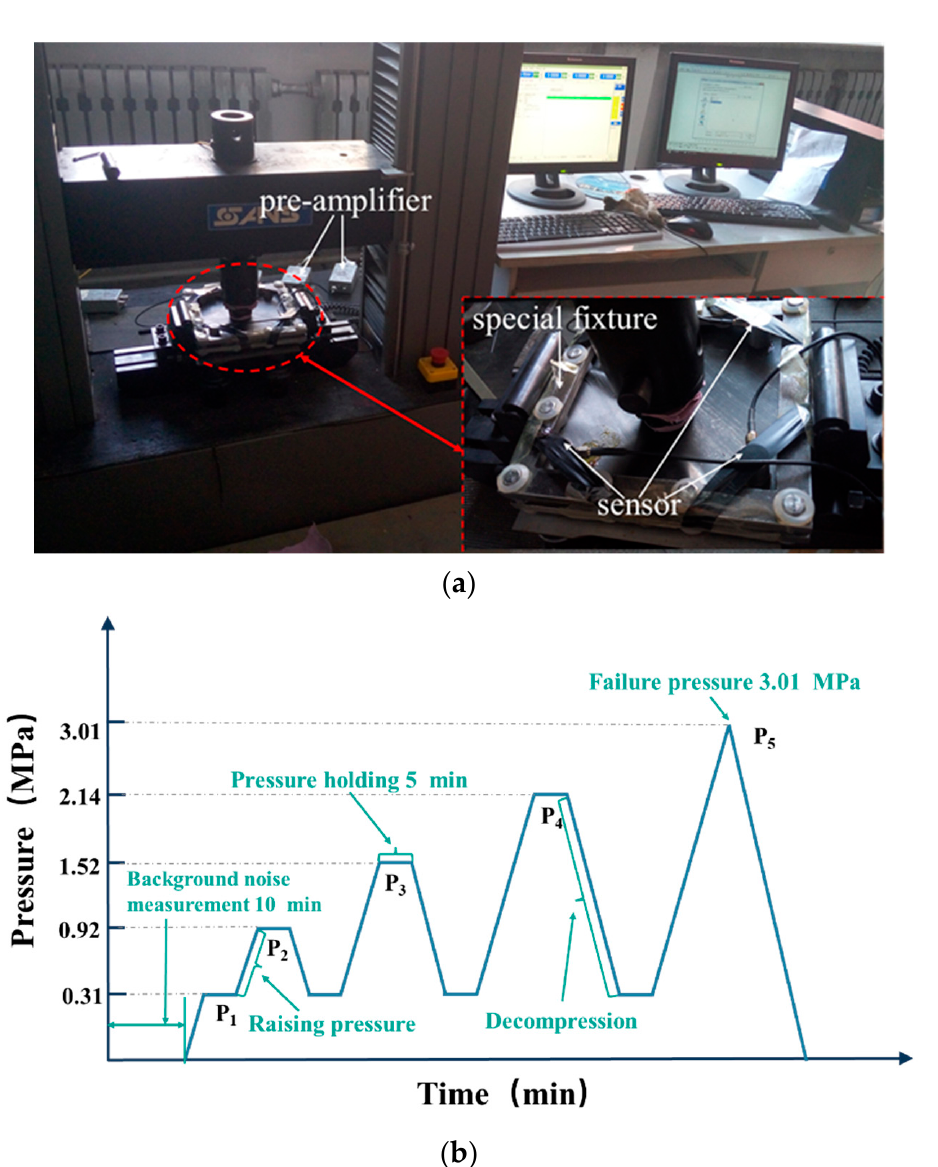
Figure 2. Bending damage AE emission monitoring ( a ), and loading curve of in-plane bending test ( b ).